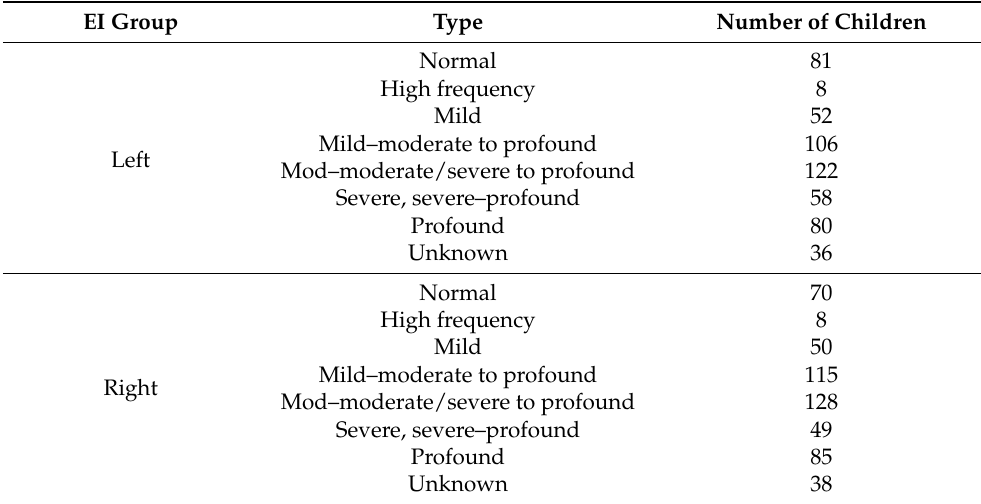
Table 6. Early Intervention (EI) group by level of bilateral hearing loss